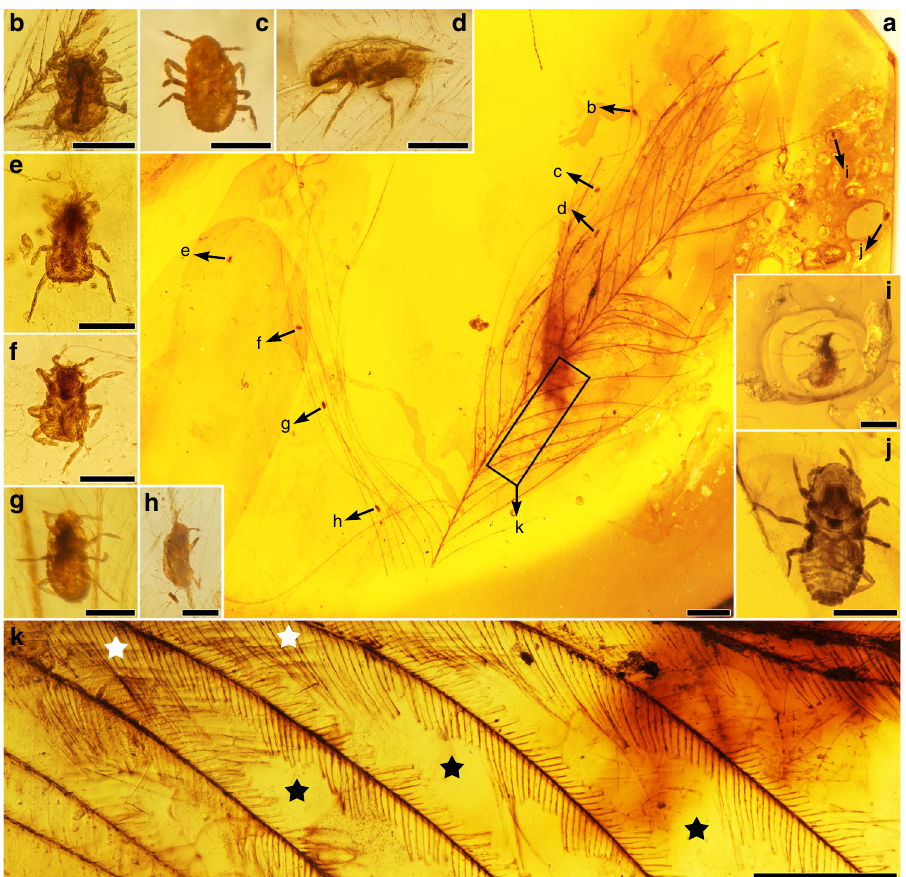
Fig. 1 AMBER No. 01 with the specimens of Mesophthirus engeli Gao, Shih, Rasnitsyn & Ren, gen. et sp. nov. from the mid-Cretaceous of Myanmar. a Photo of the whole feather and the locations of the insects, corresponding to the Supplementary Fig. 1. b – i Paratypic specimens CNU-MA2016001 to CNU- MA2016008. j Holotypic specimen CNU-MA2016009. k Parts of the feather show complete areas at basal part and adjacent largely damaged area between barbs. Representative, star in white referring to relatively complete barbules, star in blank referring to large areas of damages. Scale bars, 1